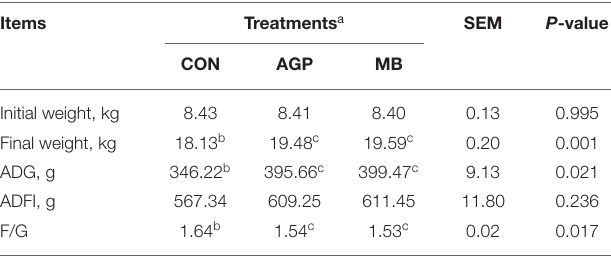
TABLE 2 | Effects of dietary Macleaya cordata extract and Benzoic acid supplementation on growth performance of weaned piglets.